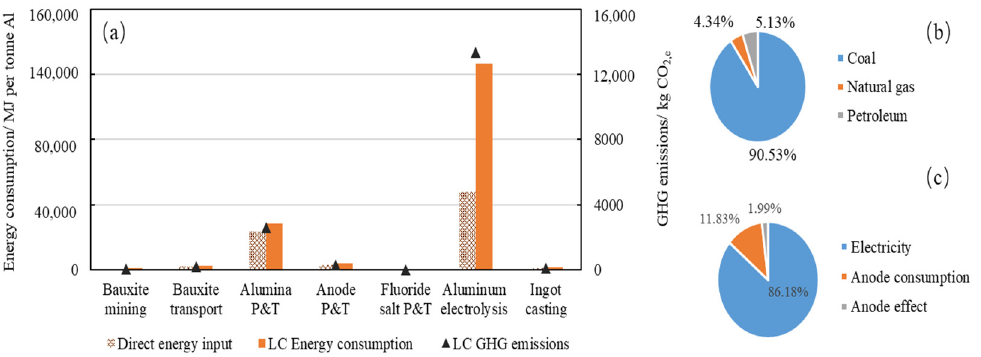
Figure 2. LC results of primary aluminum in mainland China in 2020: ( a ) Direct energy input, LC PE consumption, and GHG emissions of each stage/process; ( b ) Proportion of each primary fossil energy; ( c ) Breakdown of GHG emissions of aluminum electrolysis.